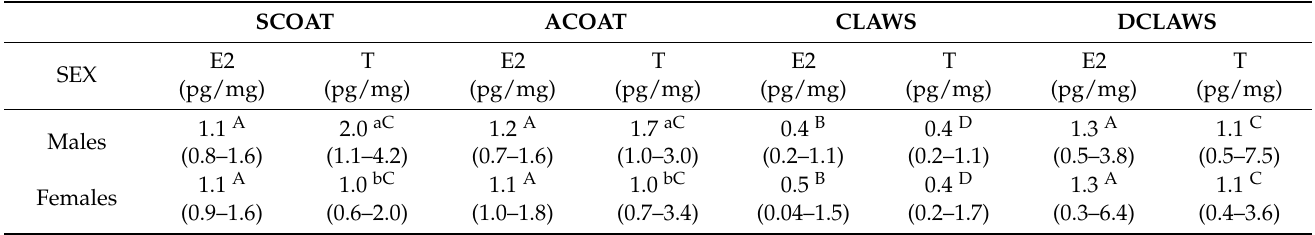
Table 1. Data regarding E2 and T concentrations (pg/mg) (median and min–max values) in SCOAT, ACOAT, DCLAWS and CLAWS in male and female postpubertal